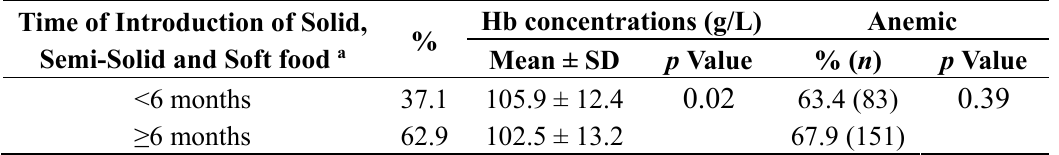
Table 6. Hemoglobin concentrations and anemia prevalence among non-formula fed infants in rural Shaanxi Province, by infant feeding practice ( N =